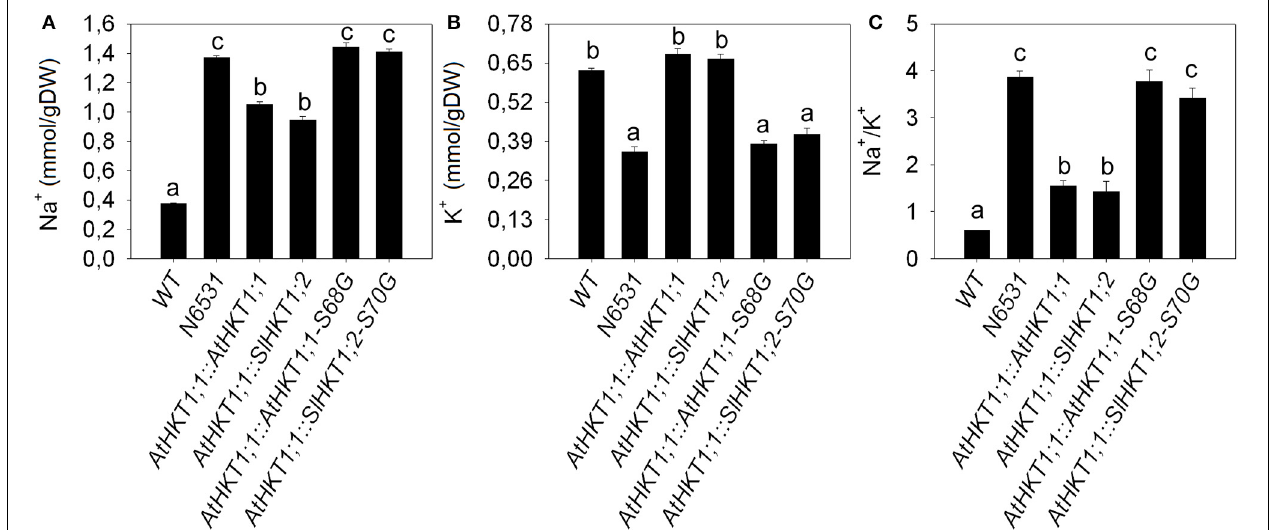
expressing AtHKT1;1 :: AtHKT1;1 or AtHKT1;1 :: SlHKT1;2 were able to reduce the accumulation of Na + and increase the accumulation of K + in comparison to athkt1;1 . Lines expressing AtHKT1;1 :: AtHKT1;1-S68G or AtHKT1;1 :: SlHKT1;2-S70G were not able to ameliorate the phenotype of the athkt1;1 plants. Different letters above bars indicate statistically significant differences. Values indicate the means ± SE of three to seven biological